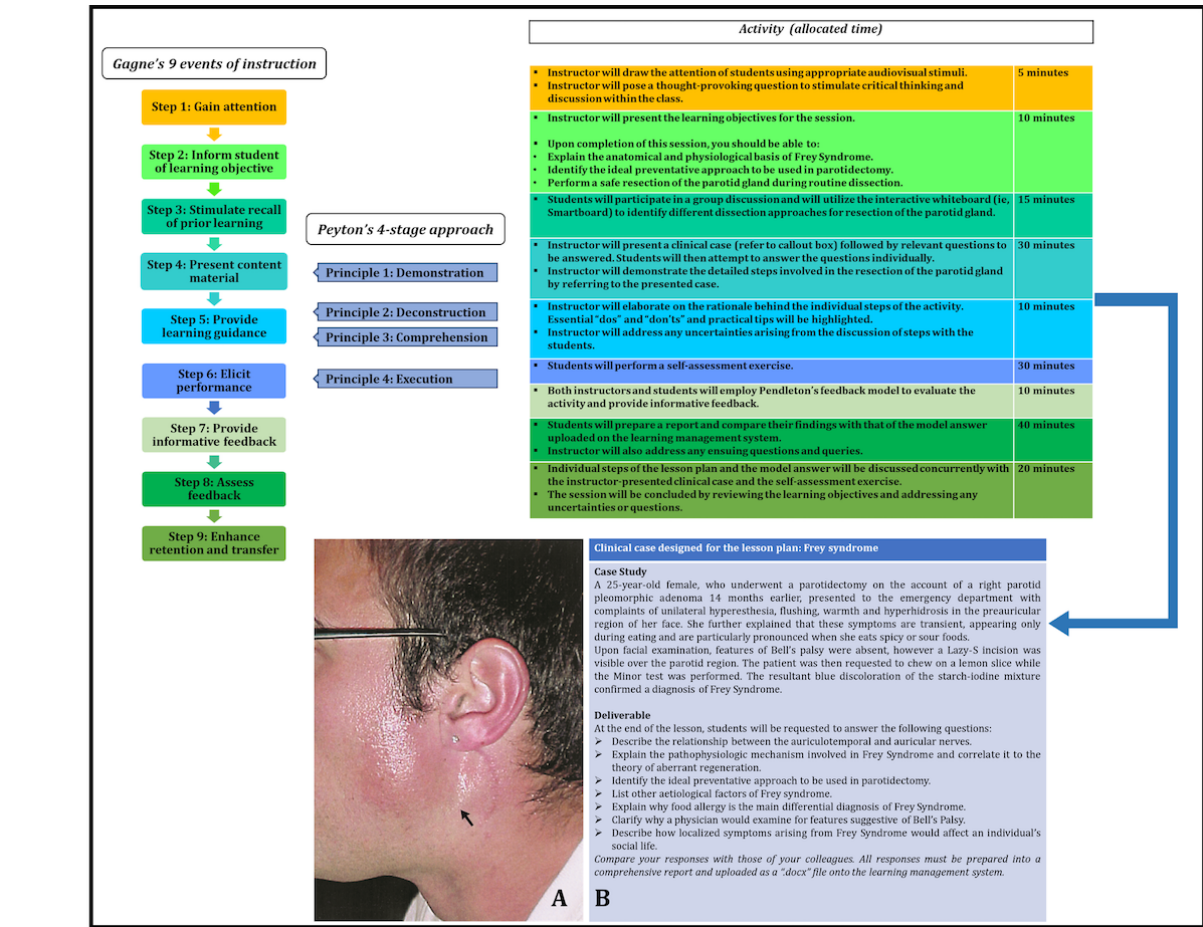
Figure 2. Design of the pedagogical framework. The instructional design strategies of Gagne and Peyton were blended to design the framework. The blended steps are also indicated. On the far right, the dissemination of the teaching framework with the sequential steps is shown with the allocated time for each step. The clinical case associated with Frey syndrome and the associated deliverables are shown. The medical image of Frey syndrome was adopted from Prattico and Perfetti [16] with permission.